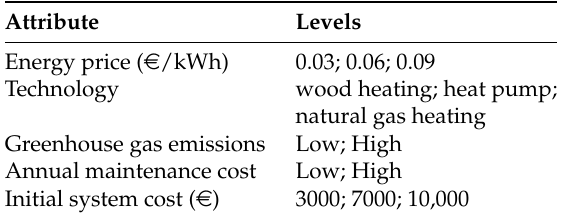
Table 1. Choice experiment attributes and their corresponding